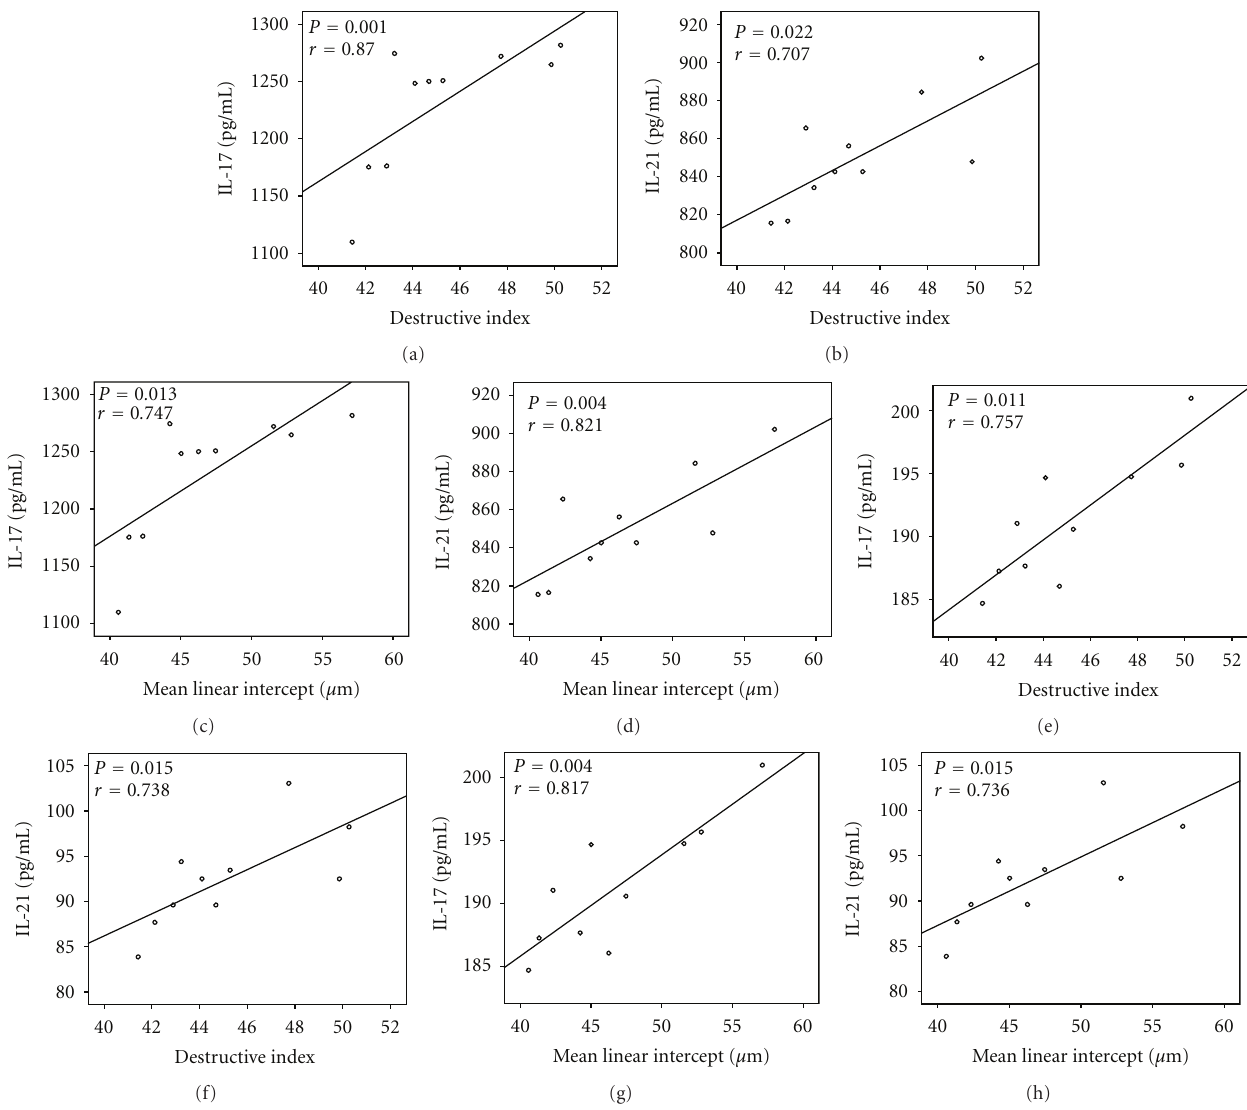
Figure 3: Correlations between (a) the protein levels of IL-17 in lungs and DI, (b) the protein levels of IL-21 in lungs and DI, (c) the protein levels of IL-17 in lungs and Lm, (d) the protein levels of IL-21 in lungs and Lm, (e) the protein levels of IL-17 in peripheral blood and DI, (f) the protein levels of IL-21 in peripheral blood and DI, (g) the protein levels of IL-17 in peripheral blood and Lm, and (h) the protein levels of IL-21 in peripheral blood and Lm. Data were determined by Pearson’s rank correlation coe ffi cients.